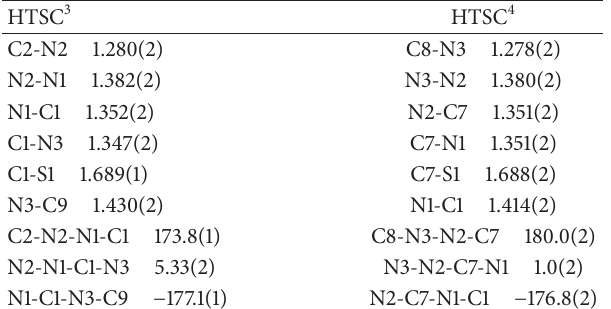
Table 2: Bond length (˚A) and torsion angles ( ∘ ) for HTSC 3 and HTSC 4 .